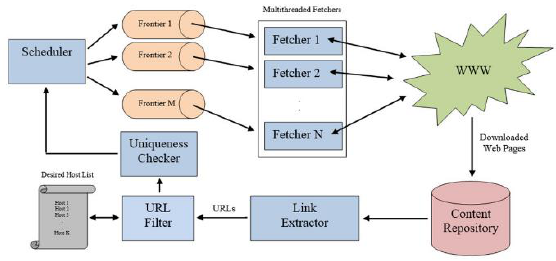
Figure 3. Simple Crawler